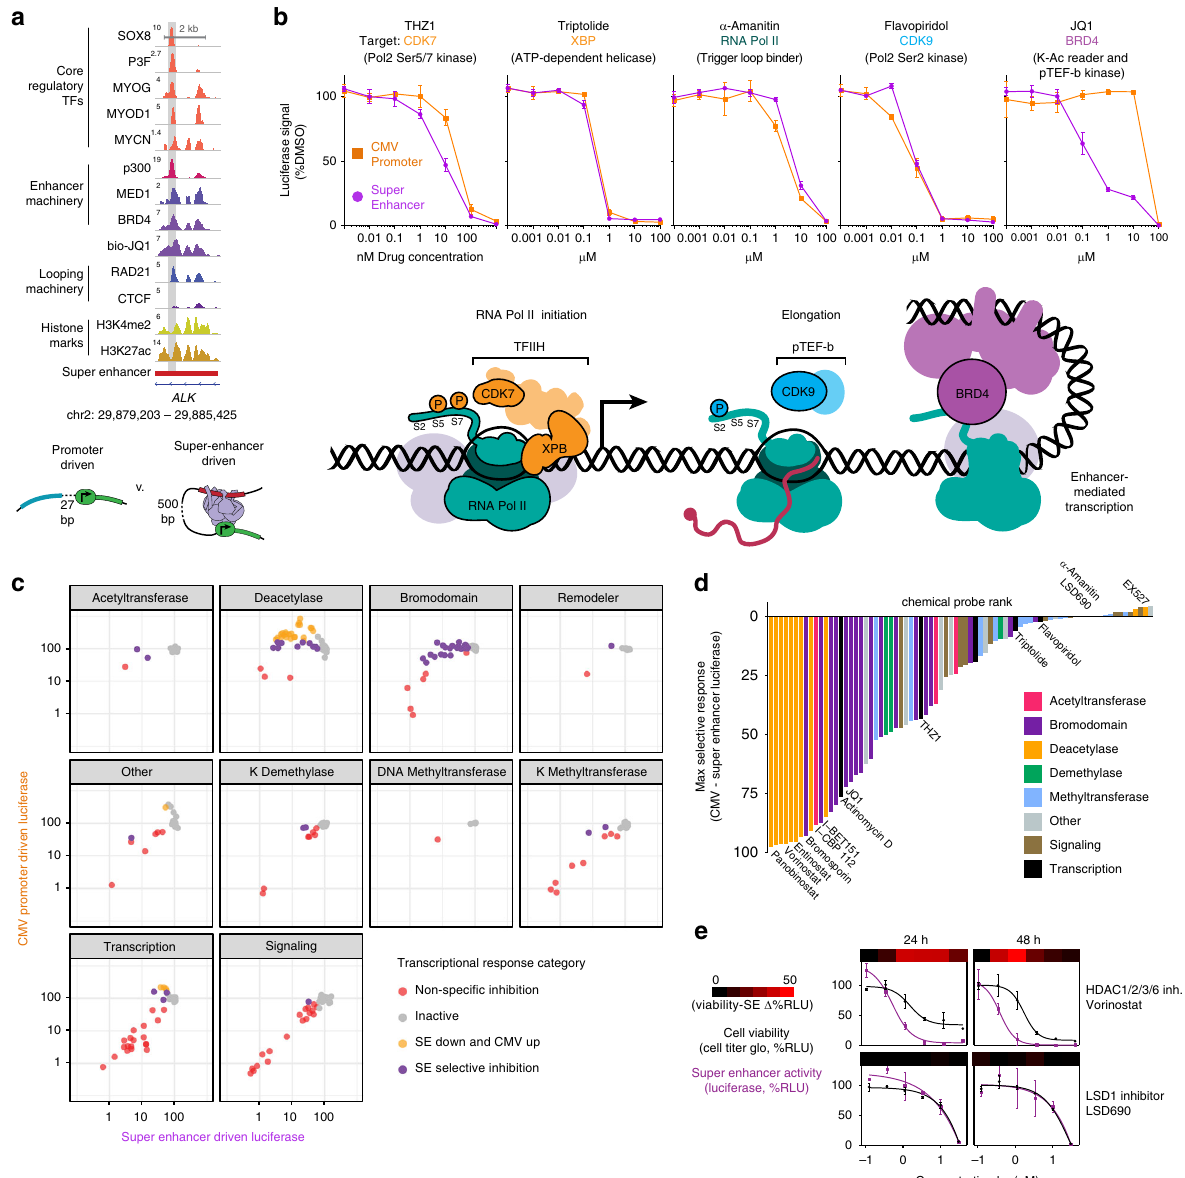
Fig. 1 Chemical genomics of core regulatory TF-driven transcription. a Genetic regulatory element activated by CR TFs at the ALK SE in FP-RMS. CR TF- binding region highlighted in gray was cloned upstream of luciferase into a lentiviral expression vector for high-throughput chemical screening. b Chemical benchmarking of CMV-promoter driven transcription vs. super enhancer-driven transcription, by dose-dependent inhibition of luciferase expression in FP- RMS cells (RH4). Compounds shown are illustrative of key steps in RNA-Pol2 transcription: initiation (CDK7, XBP dependent), elongation (CDK9 dependent), and enhancer-mediated (BRD4 dependent). Measurements are mean and standard deviation of four technical replicates. c Scatter plots of chemical probe selectivity among target classes. Color representative of four transcriptional response categories as shown: non-speci fi c inhibition (high activity against both constructs), inactive, SE-down regulating which also increase CMV-promoter-driven transcription, and SE selective inhibition. d Maximum SE selectivity per compound, rank ordered. Mechanistic classes of compounds are distinguished by bar color as shown. e Overlay of SE- dependent transcriptional response with cell viability at 24 and 48 h of drug exposure for a SE-selective inhibitor (HDAC inhibitor Vorinostat) and a transcriptionally unselective compound (LSD1 inhibitor LSD690). Heatmap above dose – response curves is calculated as the difference between SE- transcription and cell viability. Points represent mean and standard deviation of three technical replicates